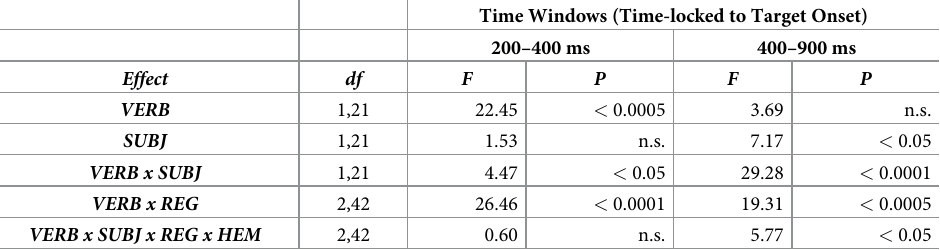
Table 8. Results of 2 x 2 x 3 x 2 Global ANOVA for the two selected time windows (200–400 ms and 400–900